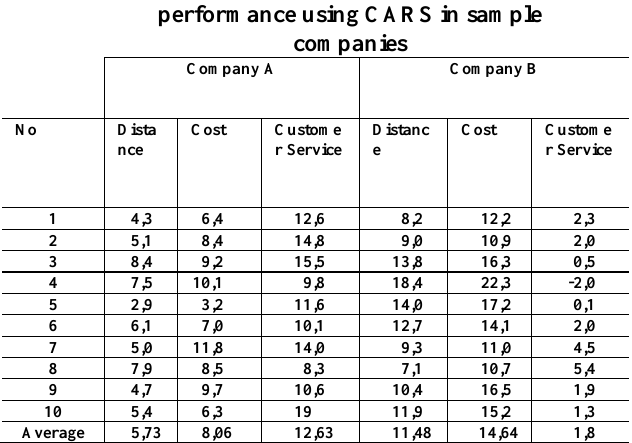
Table 3: Percent of Improvement in performance using CARS in